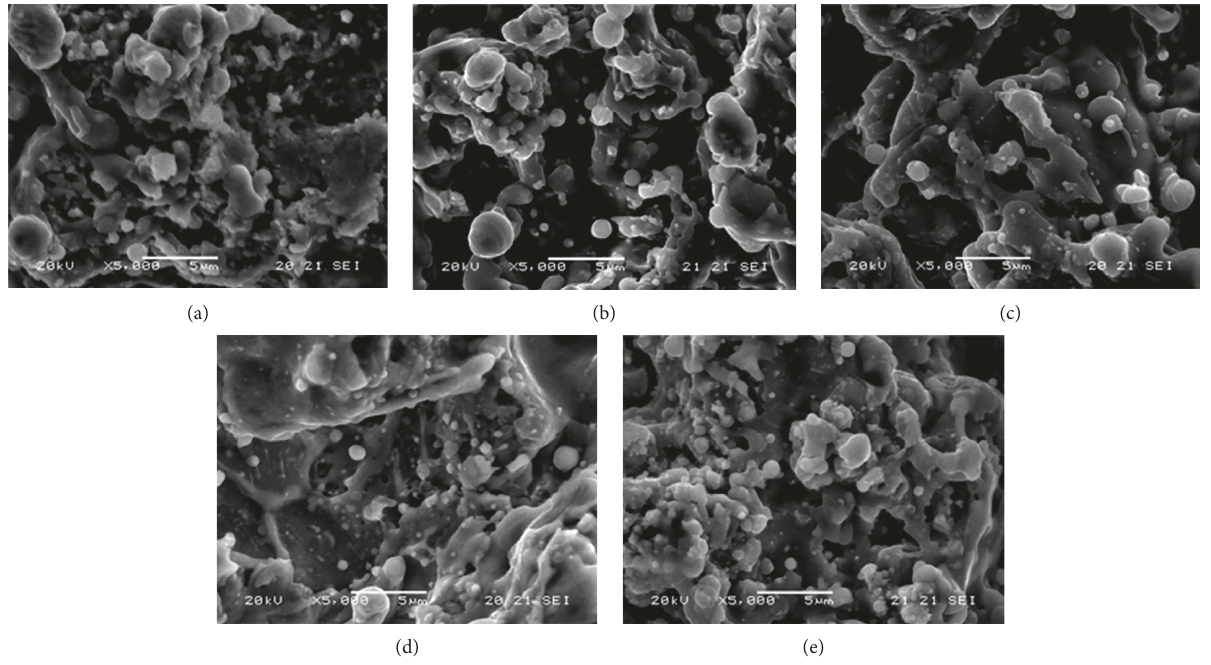
Figure 6: SEM micrographs of NiTinol coatings’ surface of samples A (a), B (b), C (c), D (d), and E